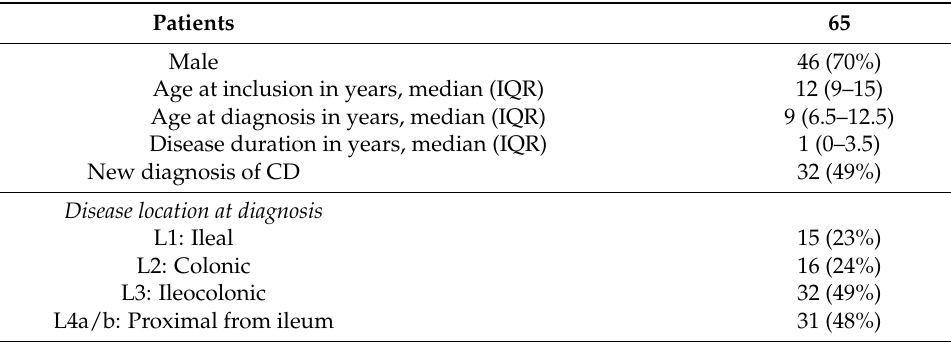
Table 1. Baseline characteristics of 65 children with Crohn’s disease